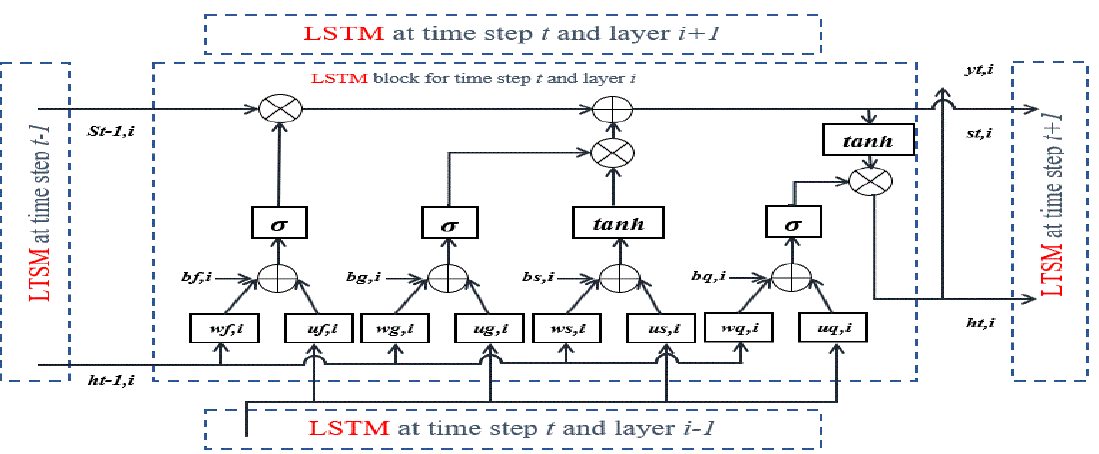
Figure 22. An LSTM block in an LSTM model is shown in this